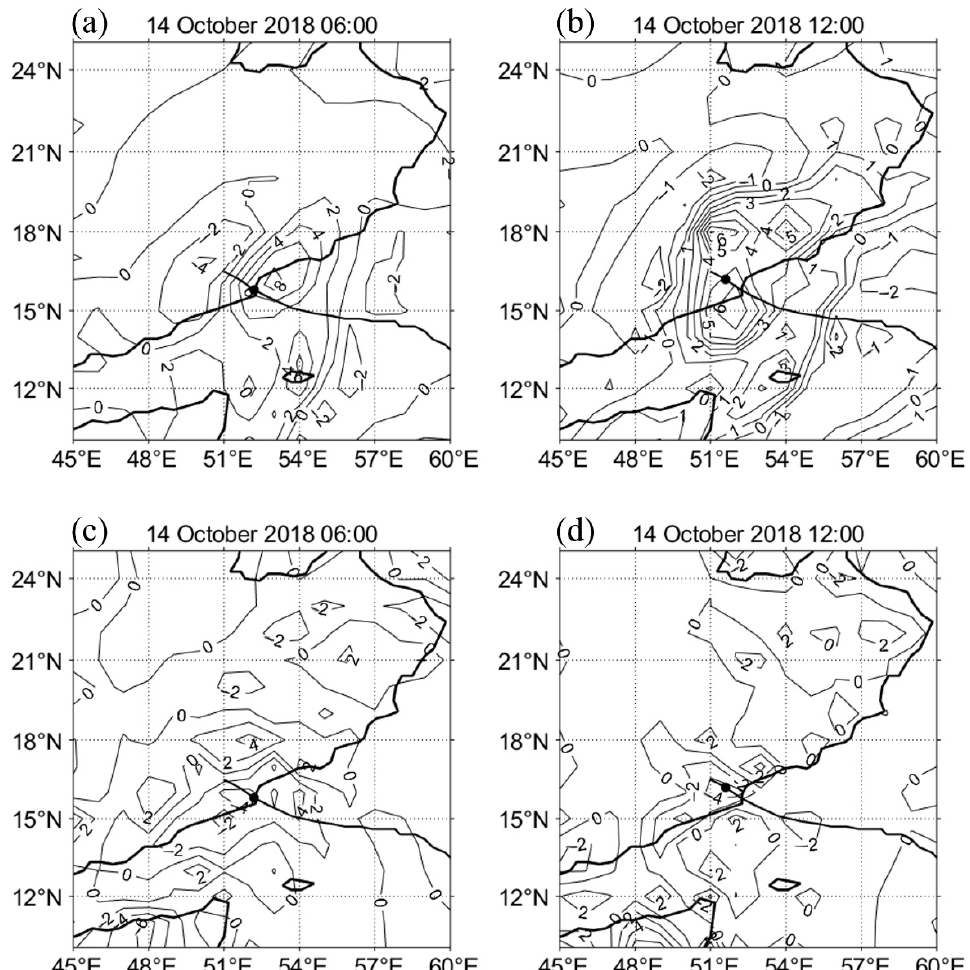
Figure 11. The divergence (10 − 5 s − 1 ) of Luban during and after landfall. ( a ) 14 October 2018 06:00, ( b ) 14 October 2018 12:00 at level = 200 hPa; ( c ) 14 October 2018 06:00, ( d ) 14 October 2018 12:00 at level = 850 hPa. The black dot indicates the TC center.